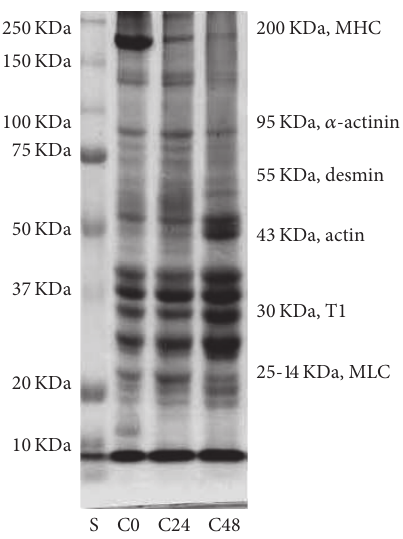
Figure 2: SDS-PAGE electrophoresis of control samples sheep ( m. Longissimusdorsi ),storedinairconditionsat0–4 ∘ b .S:standard;C0: control samples at 4 h postmortem; C24: control samples stored in air conditions at 0–4 ∘ b for 24 h; C48: control samples stored in air conditions at 0–4 ∘ b for